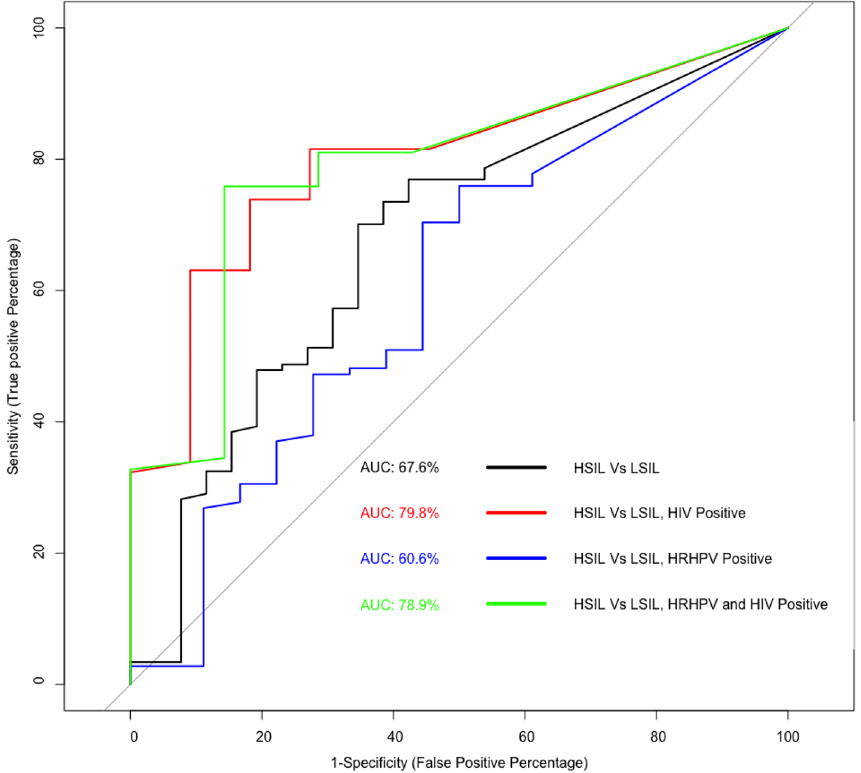
Figure 4. Receiver Operating Characteristic (ROC) curve for the percentage methylation of gene MAL for all significant (p, ≤ 0.05) comparison combinations identified in the nonparametric Wilcoxon test. Comparisons include HSIL versus LSIL in all samples (black), HSIL versus LSIL in HIV positive samples (red), HSIL versus LSIL in all HRHPV positive samples (blue) and HSIL versus LSIL in all HIV and HRHPV positive samples